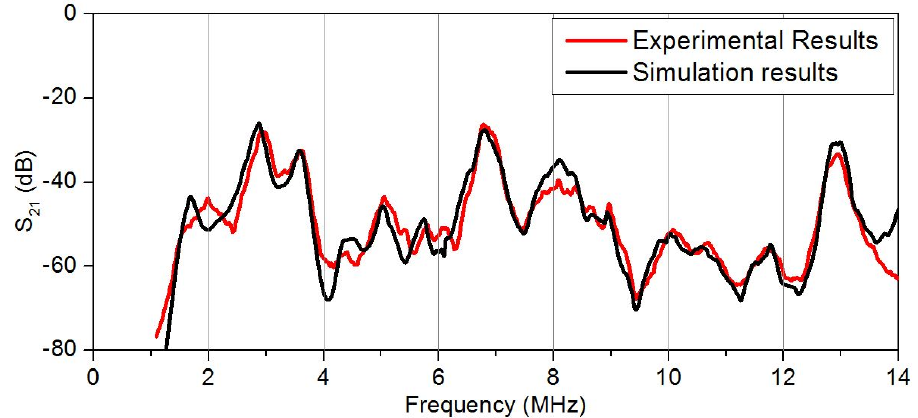
Figure 11. Comparison of simulation results with experimental data for produced delay line based on YX LiNbO3 plate.